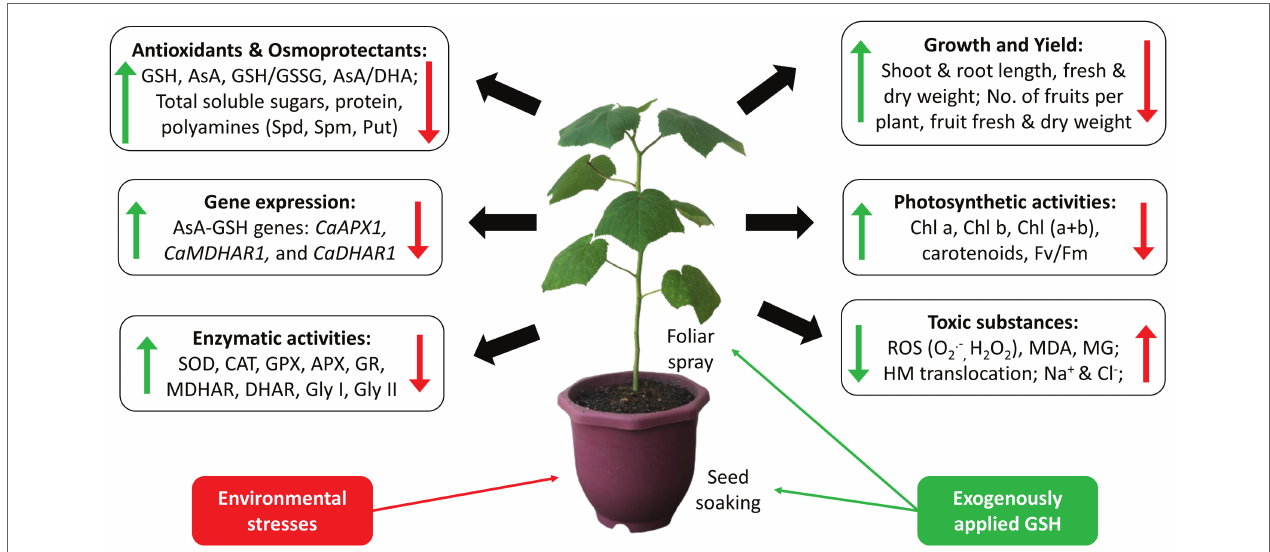
FIGURE 4 | Key effects of individual exogenous application of GSH on plants in response to environmental stresses. Red arrows indicate the effects of environmental stresses in plants; green arrows indicate effects of exogenous application of GSH in response to the environmental